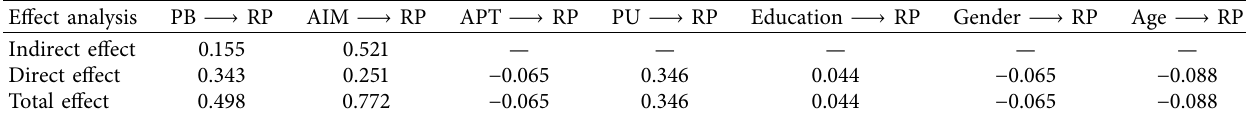
Table 6: Standardized effects on ridesplitting